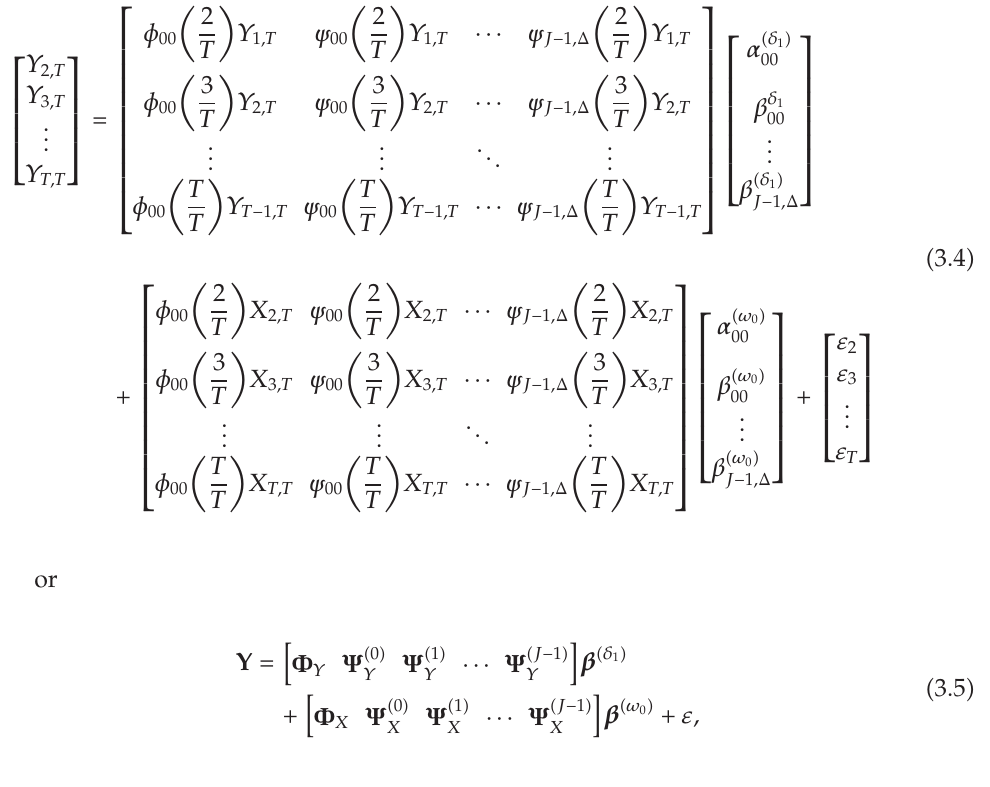
(cid:7) δ (cid:5) · (cid:6) , (cid:5) c (cid:6) (cid:7) δ (cid:5) e (cid:6) (cid:7) w (cid:5) · (cid:6) and nonlinear estimators (cid:5) b (cid:6) (cid:5) δ 1 2 , 0